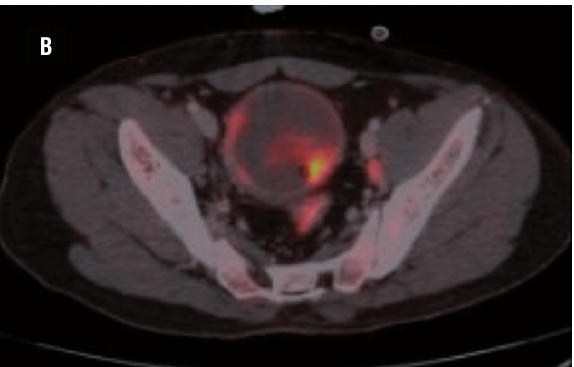
figure 5 - pET / CT showing moderate fDg uptake in left internal iliac nodes (arrow).